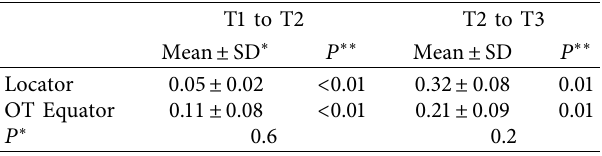
Figure 4: Radiographic tracing for periapical X-ray film. The mesial and the distal lines (red and yellow, respectively) parallel for each other and perpendicular to reference (green) line. Table 1: MBL change within 12 months of implants loading.